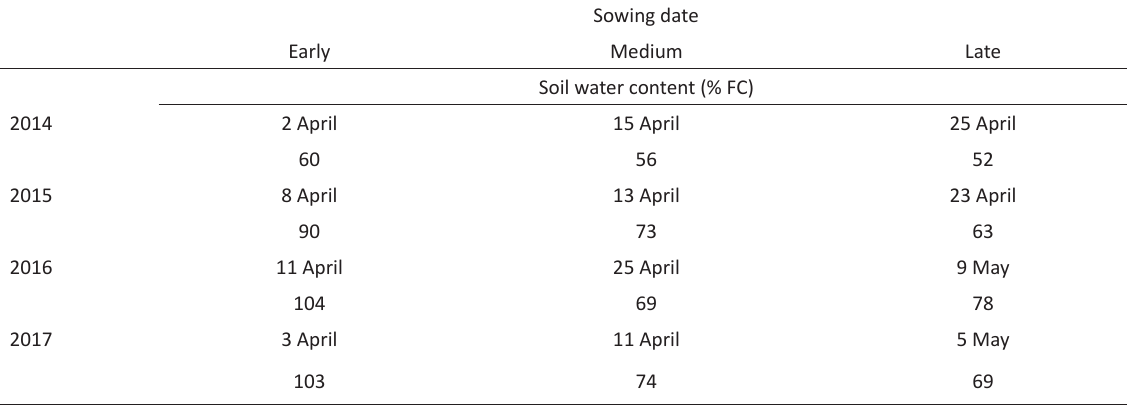
Table 2. Actual dates for different sowing time and their associated mean soil water content at 5–10 cm depth, presented in % of field capacity (FC), in spring 2014–2017 at